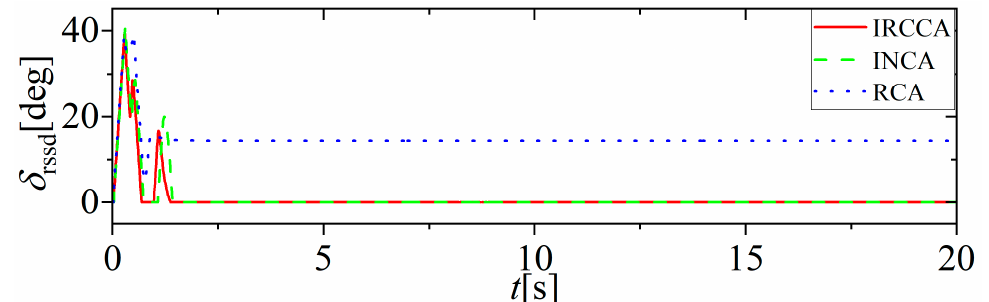
δ deflection. rssd